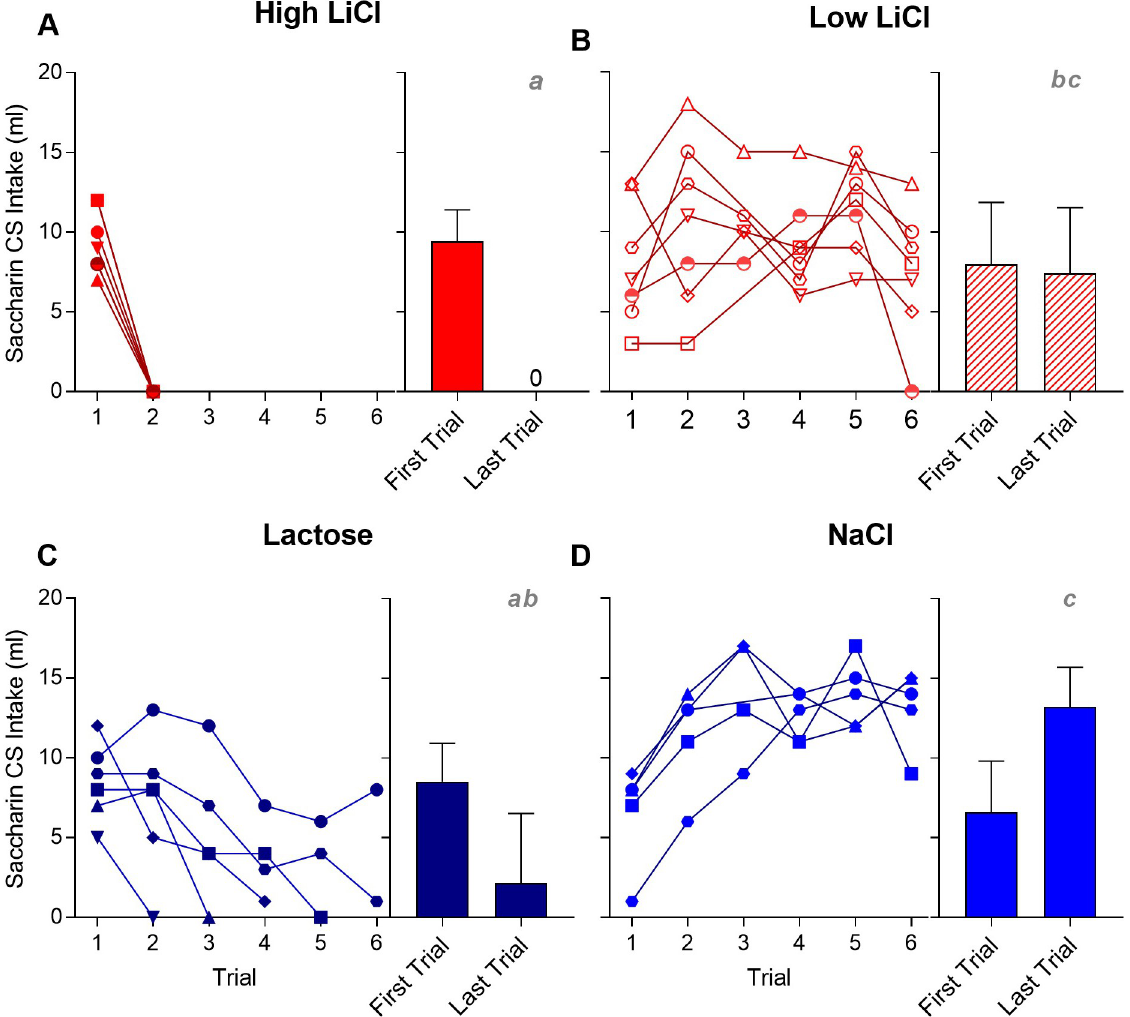
Fig 1. Saccharin CS intake is plotted across taste-ID conditioning trials for all individual rats within each training group [High LiCl, A ; Low LiCl, B ; Lactose, C ; NaCl, D ] in Experiment 1a. Group mean ± SEM saccharin CS intake on the first and last training trials is shown to the right of the individual plots. A given rat in each training group is represented by the same symbol across all Experiment 1a figures. Histograms with different gray letters were found to be significantly different from one another with post hoc t-tests, Bonferroni-corrected for multiple